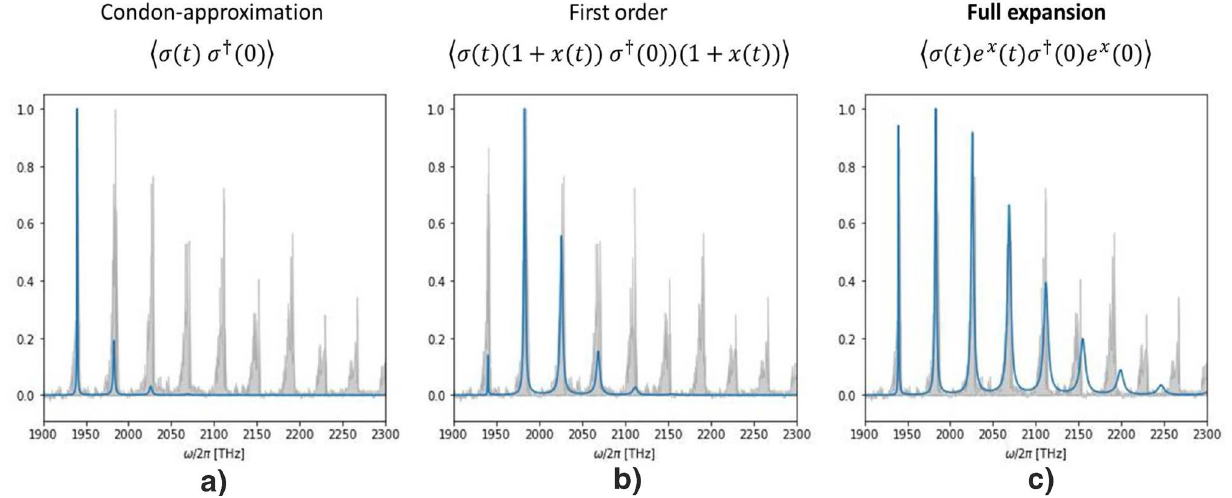
Figure 2. Absorption lineshape of carbon monoxide at 303 K. Blue-solid lines show theoretical model and grey background shows experimental data obtained from 43 (digitalized). The dipole matrix elements M eg and M ge are expanded with respect to the nuclear coordinates x in different orders: ( a ) Condon-approximation ( b ) Truncated at first-order (Herzberg–Teller) term ( c ) full exponential. The parameters: ω eg = 2 π × 1940THz , v ( g ) = v ( e ) = 2 π × 43THz , s = 0.62 × 10 − 11 m, ω c = 2 π × 5.7 THz , Ŵ = 10 9 GHz and m = 1.1 × 10 − 26